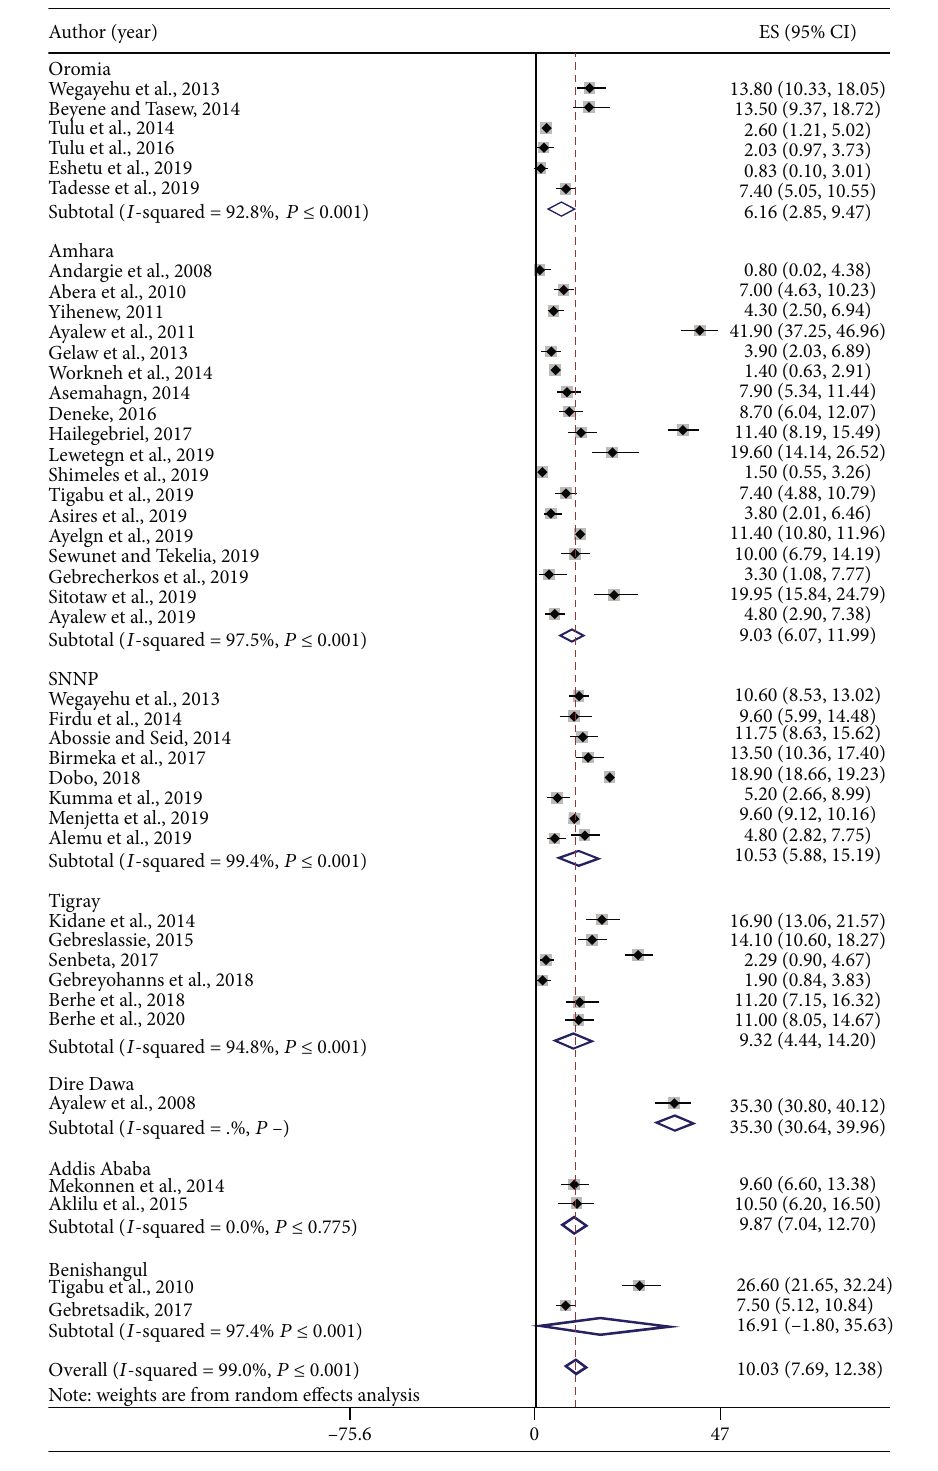
Figure 4: The pooled prevalence of G . lamblia among study participants in